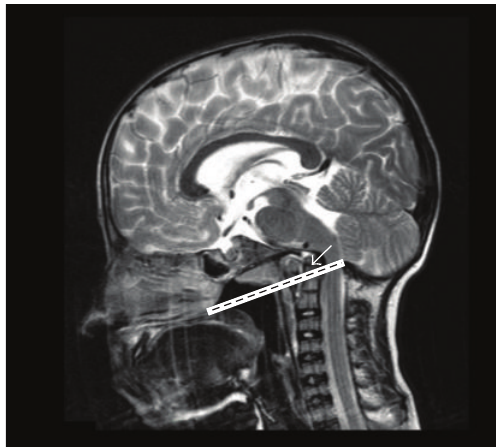
Figure 6: Basilar impression on brain MRI. The tip of the odontoid process (arrow) projects > 5mm above the Chamberlain line (line between the hard palate and the opisthion which is the midpoint on the posterior margin of the foramen magnum).